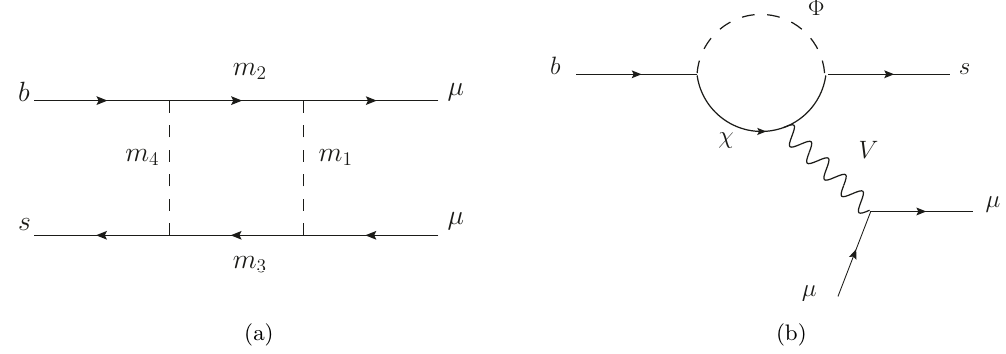
Figure 1 . (a) Example box loop mediating the B -meson decay. (b) Example penguin loop medi- ating the B -meson